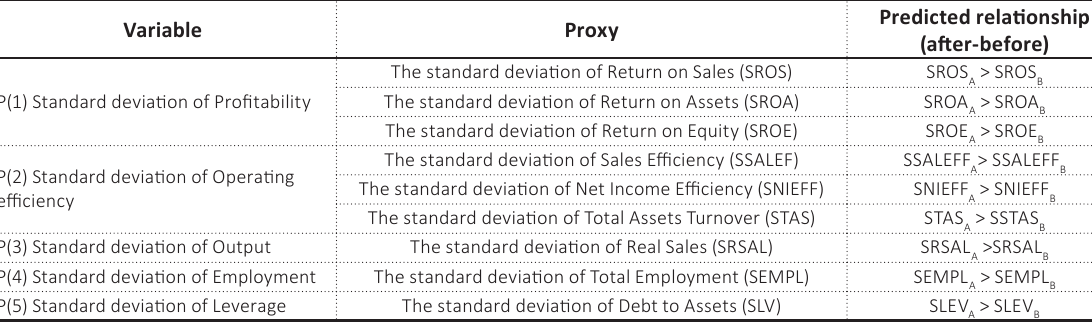
Table 2. Summary of testable standard deviation